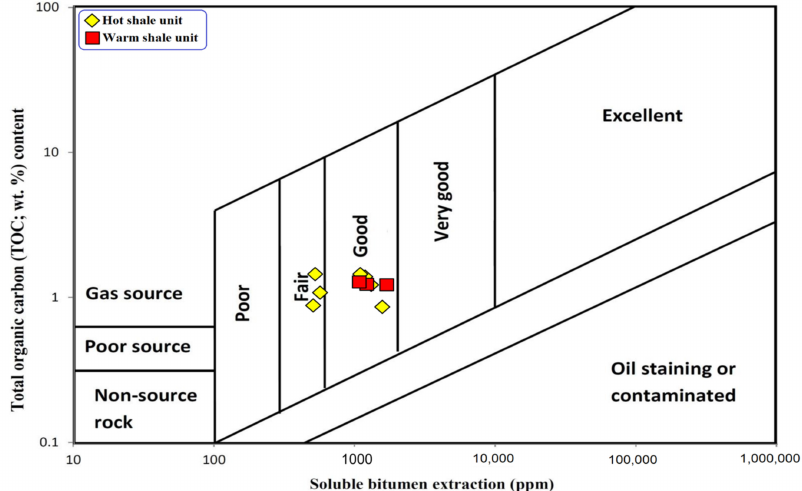
Figure 5. Relationship between TOC content and soluble bitumen extraction of the analyzed shales of the Qusaiba units, suggesting a fair to good organic matter